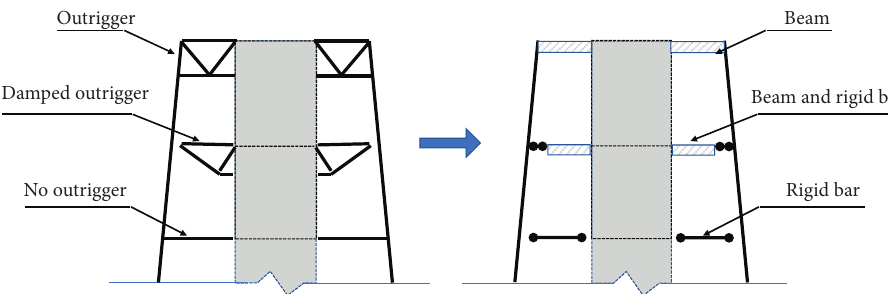
Figure 5: Simplified method of the mega-frame beam element.